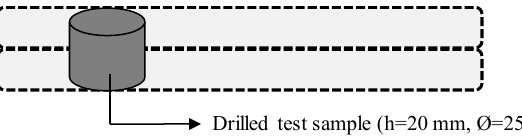
Figure 4. Schematic illustration of sampling element.